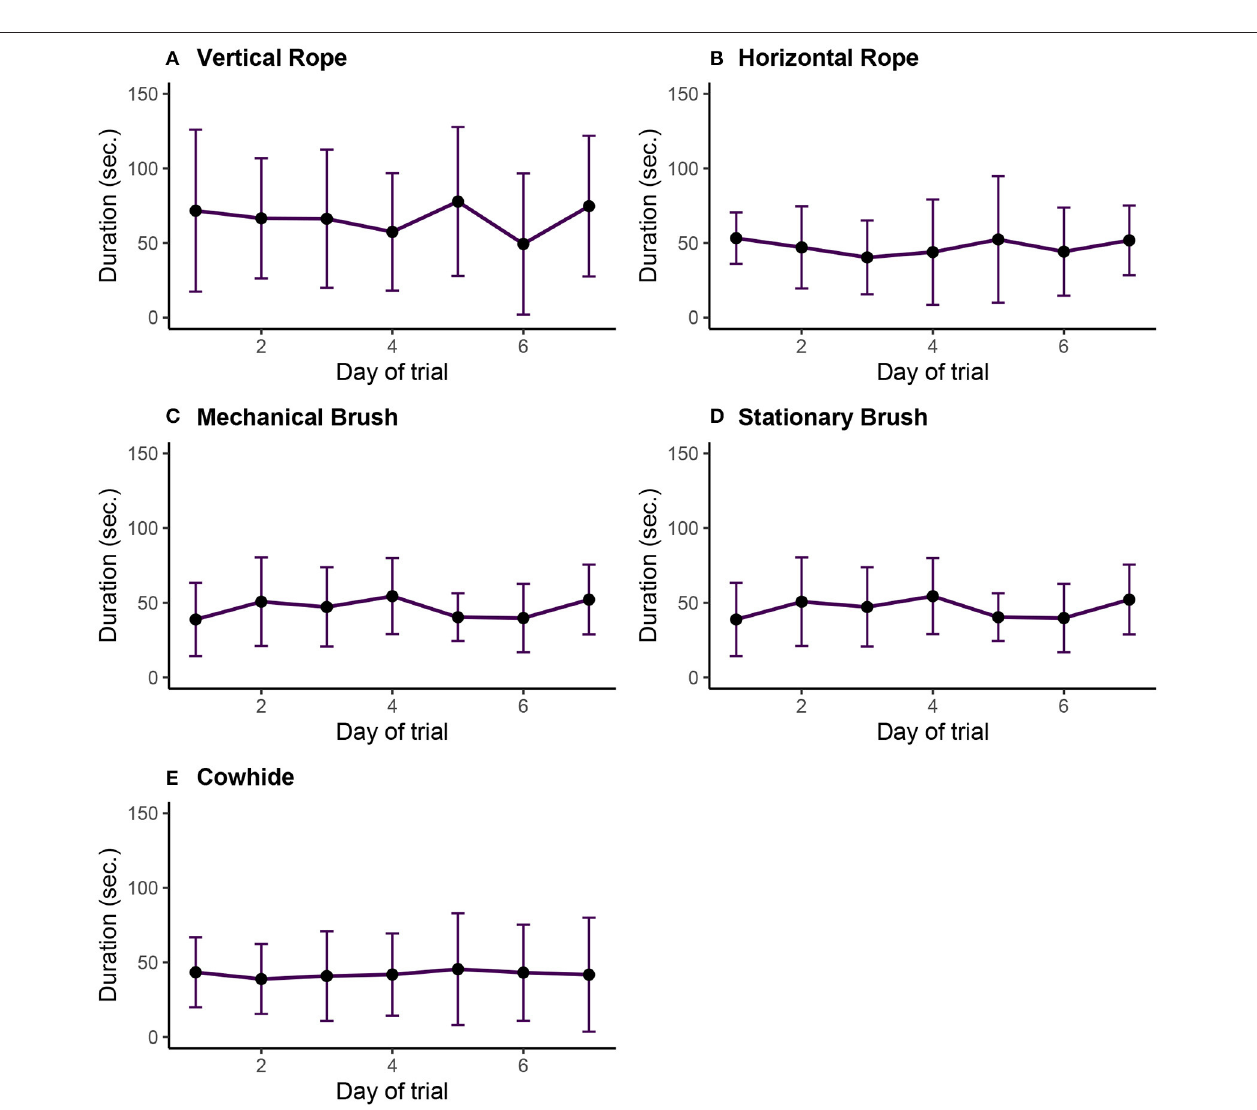
FIGURE 4 | (A–E) Average (mean ± SE) of time spent interacting with each environmental enrichment object by day of study for using five enrichment objects observed in 25 calves kept in groups of five for five replicates recorded continuously 12h per day, for 1 week, based on raw data. (A) Vertical rope, (B) horizontal rope, (C) mechanical brush, (D) stationary brush, and (E)